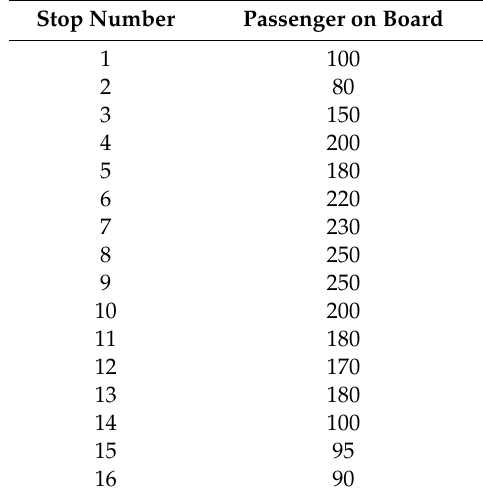
Table 7. Passenger variation at each stop during tramway operations.